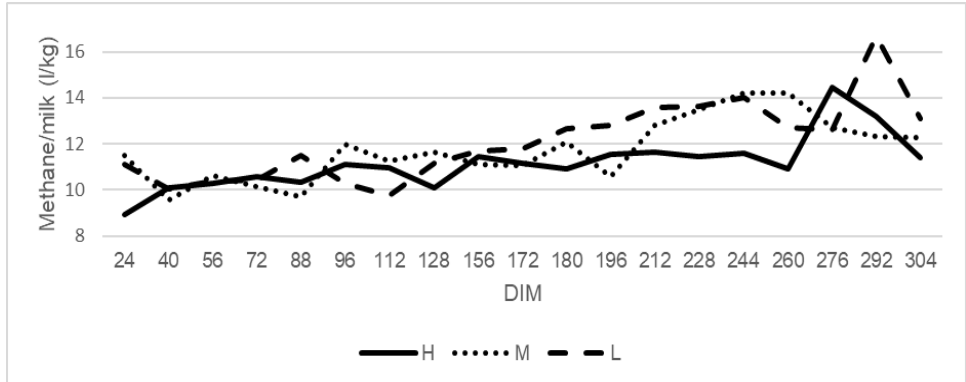
Figure 4. The trend for methane emission on milk production (CH4/milk) in cows classified as high (H), medium (M), and low (L) rumination animals. High rumination (H) from 527 min/day, medium rumination (M) from 412 to 527 min/day, and low rumination (L) to 412 min/day.